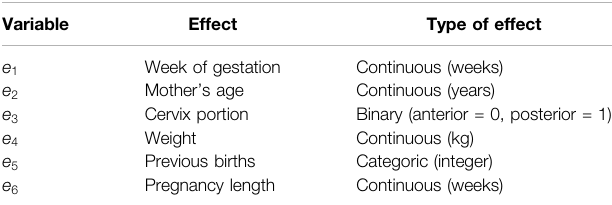
TABLE 2 | Variables of the mixed effects model applied to the optimized dispersion